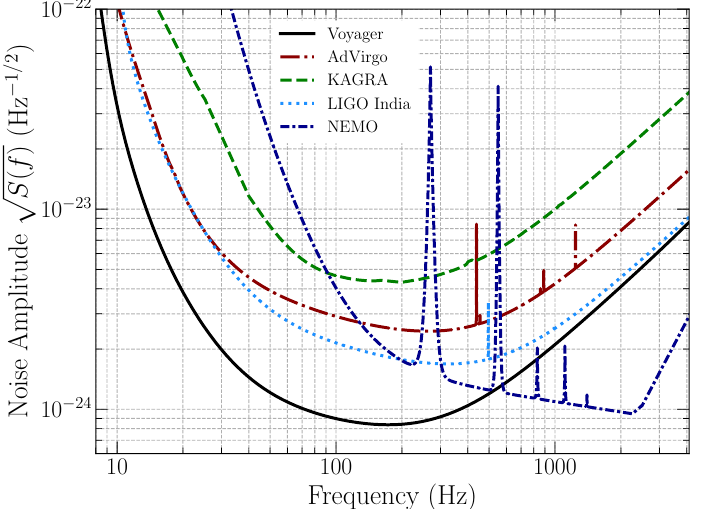
Figure 1. Sensitivities of the detectors projected to operate in the late 2020s and early 2030s. NEMO detector is designed to measure the high-frequency GW signal from binary neutron star